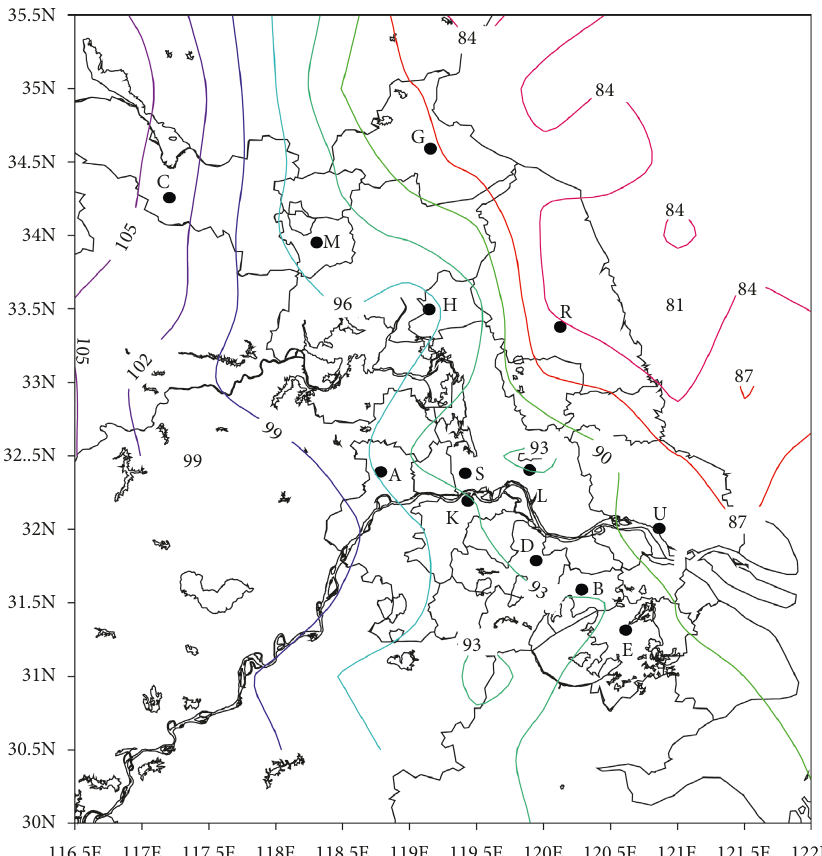
Figure 5: Spatial distribution of the annual average value of the AQI in Jiangsu Province in the period